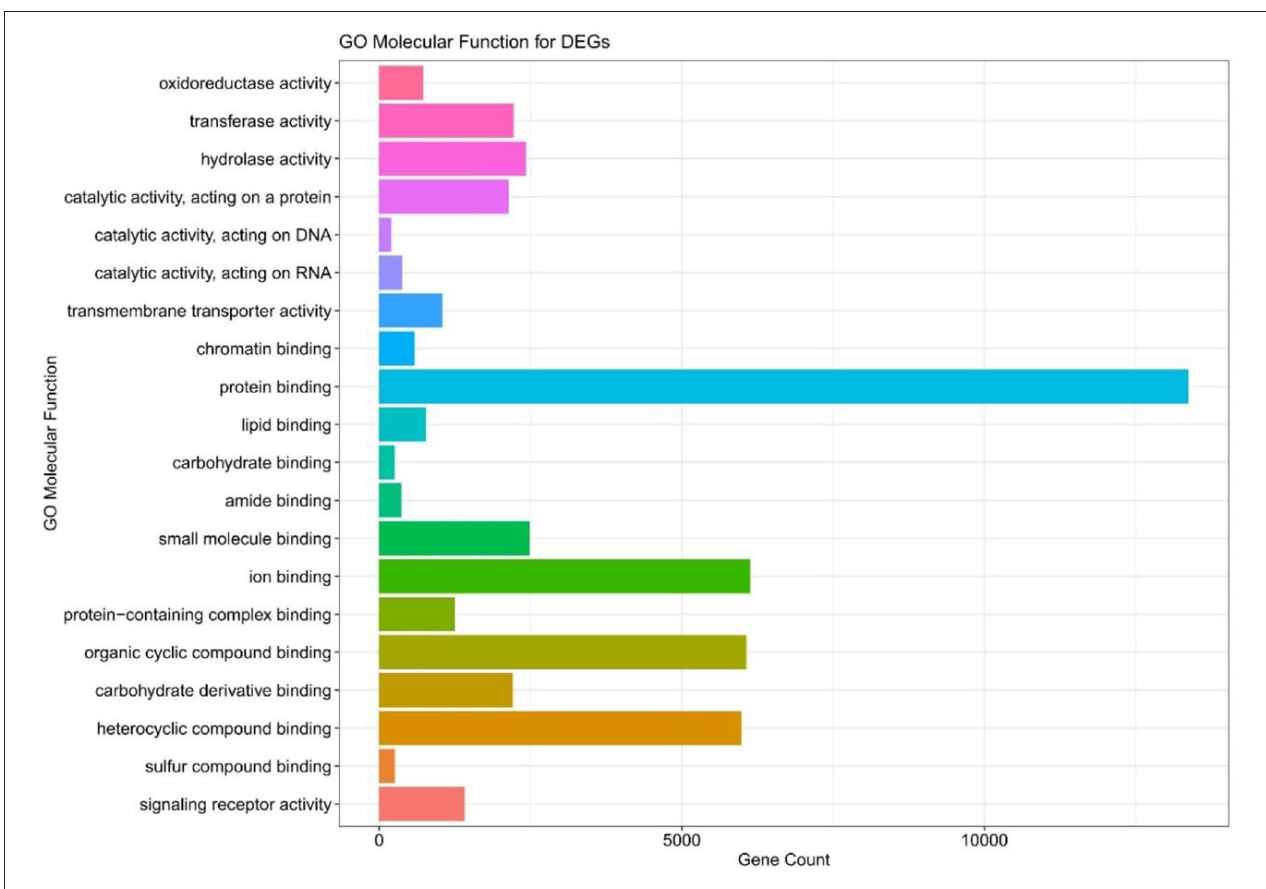
FIGURE 6 | The GO molecular function terms of the DEGs in all compared